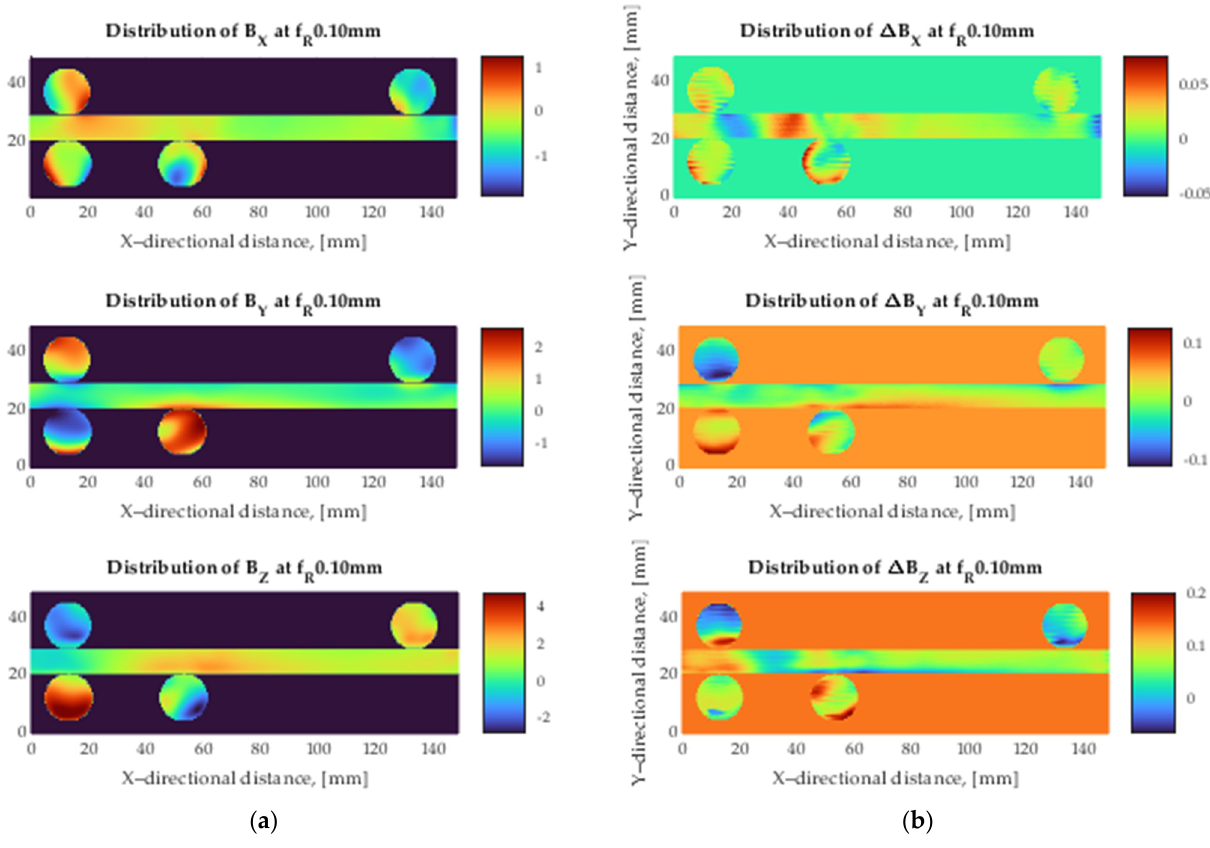
Figure 3. Experimental results: ( a ) distribution of the magnetic flux density, B X , B Y , and B Z ; ( b ) distribution of the subtract magnetic flux density, ∆ B X , ∆ B Y and ∆ B Z